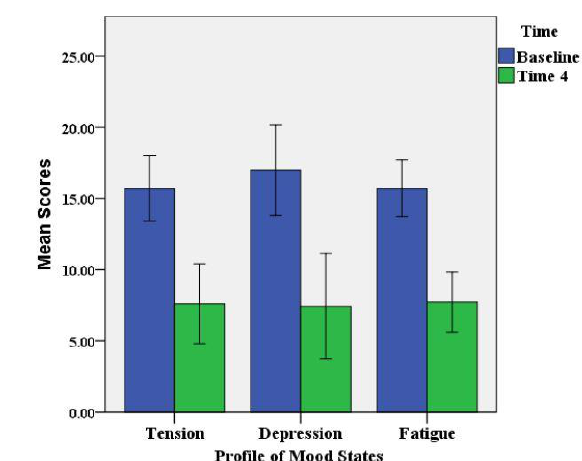
Figure 2. Changes in Profile of Mood States from Baseline to Time 4 n = 18; T-bars indicate standard error. As correlational analyses were conducted on available data points at Time 2, it was important to rule out the possible confounding effect of dropout on SC associations. An independent samples t-test was used to compare self- criticism in the sub-sample who completed our MM program (completers) and all dropouts. There was no significant difference in SC scores for program completers ( x = 0.116; SD = 0.154) vs. non-completers ( x =